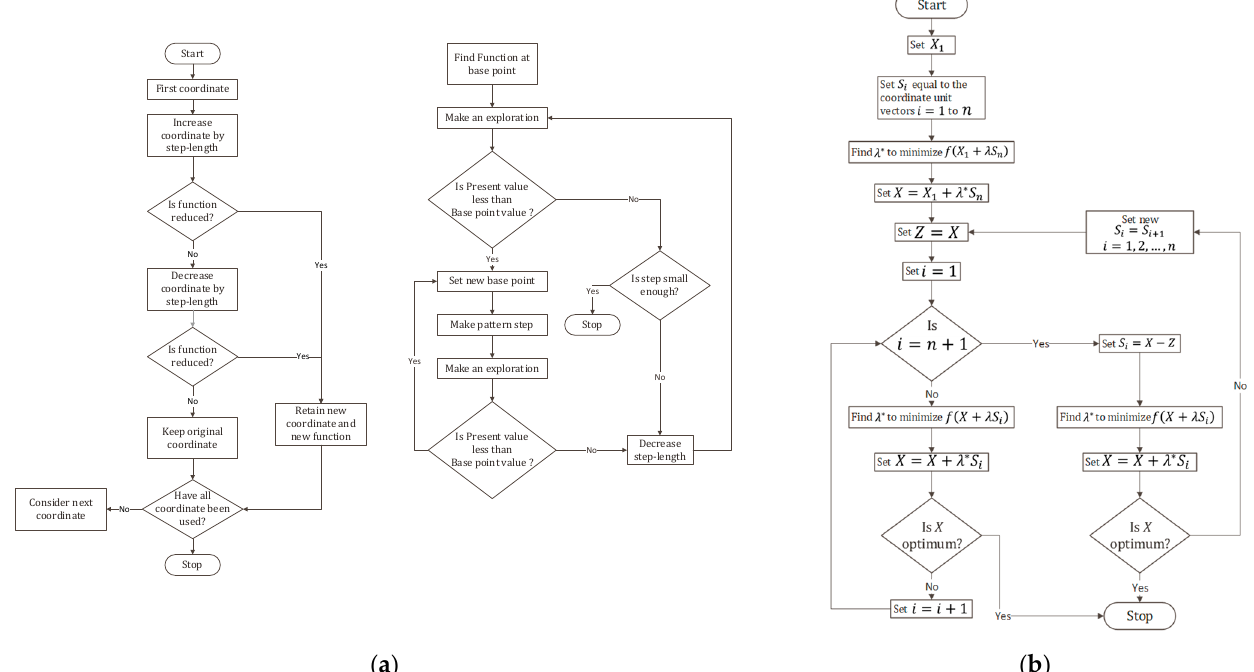
Figure 3. ( a ) Flowchart representation of the Hook and Jeeves’ optimization algorithm [64] and ( b ) flowchart representation of the Powell’s optimization algorithm [49].